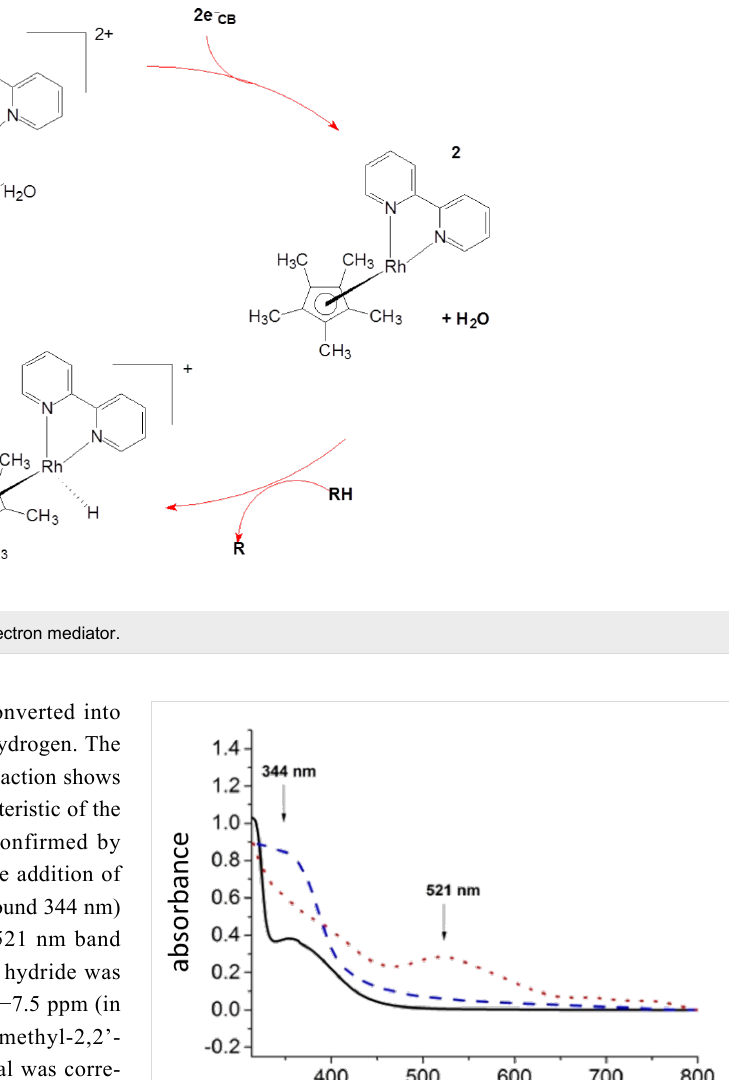
Figure 8: UV–vis absorption spectra of an aqueous solution of [Cp*Rh(bpy)(H 2 O)] 2+ . Continuous black line: spectrum of the starting rhodium complex in water. Dotted red line: spectrum of the rhodium complex after treatment with hydrogen. Dashed blue line: spectrum of the rhodium-hydrido complex after addition of NAD + : the band at 521 nm disappears and the band at 344 nm attributed to NADH